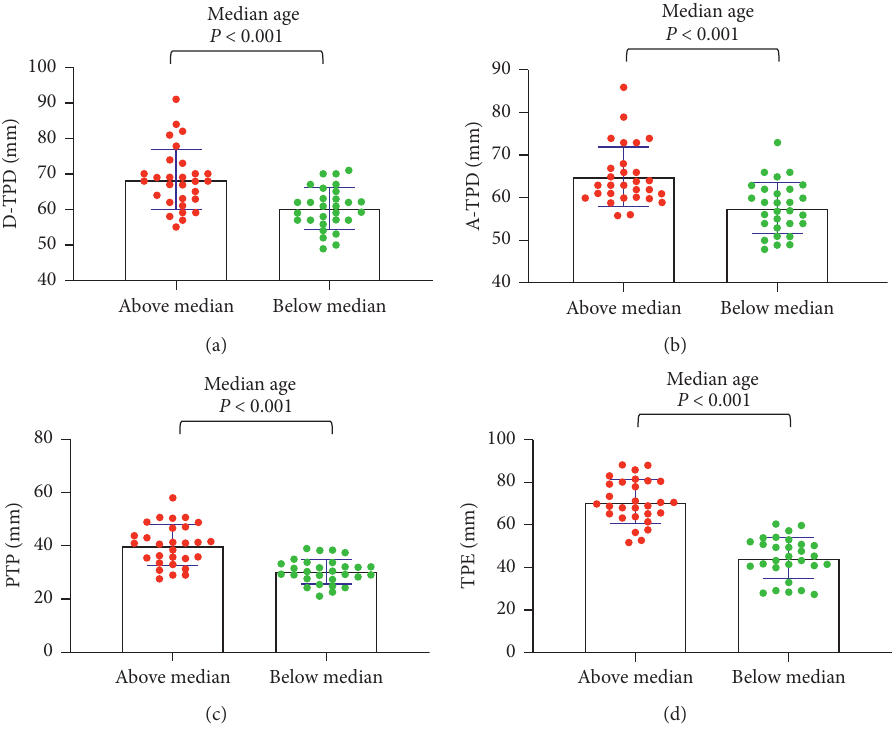
Figure 1: Tactile acuity for median age in the abovemedian group versus the belowmedian group. (a) D-TPD, (b) A-TPD, (c) PTP, and (d) TPE. The median of age was 32 years. D-TPD � two-point discrimination test performed in a descending manner; A-TPD � two-point discrimination test performed in an ascending manner; PTP � point-to-point test; TPE � two-point